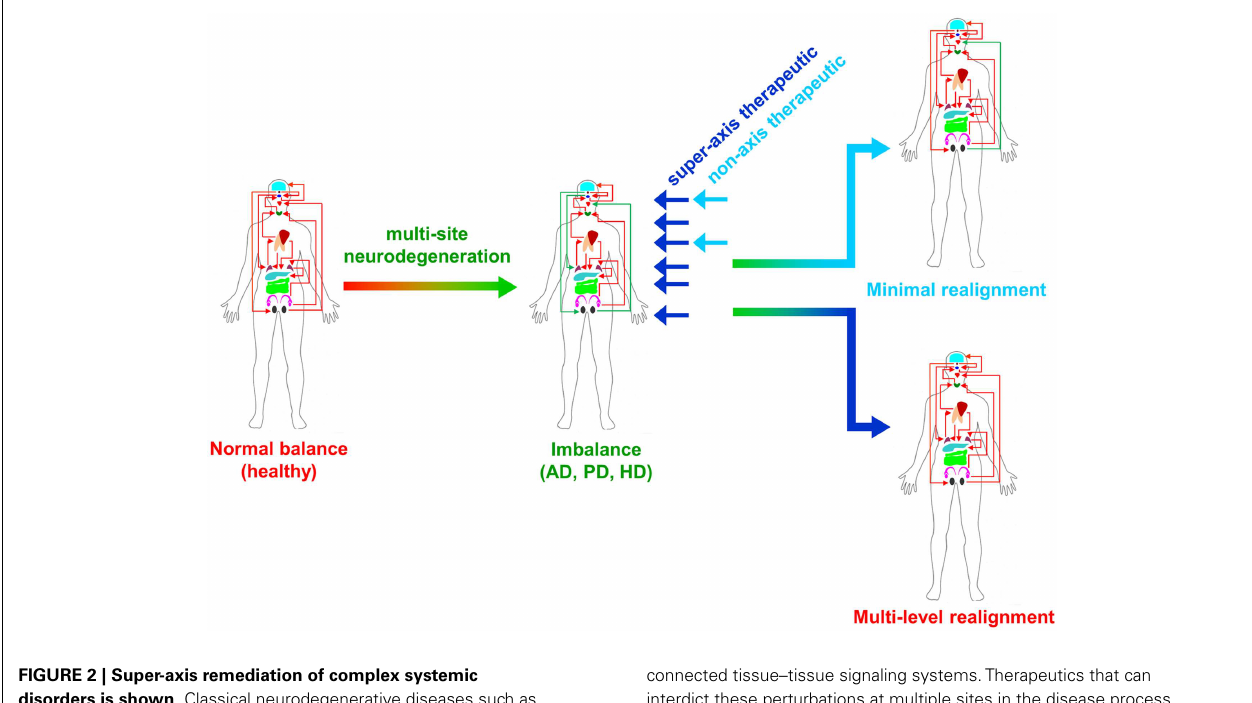
FIGURE 2 | Super-axis remediation of complex systemic disorders is shown . Classical neurodegenerative diseases such as Alzheimer’s, Parkinson’s, and Huntington’s disease (AD, PD, and HD) represent intensely complex pathophysiological perturbations of normal systemic biology.These neurodegenerative disorders generate their full phenotypes through the disruption of multiple